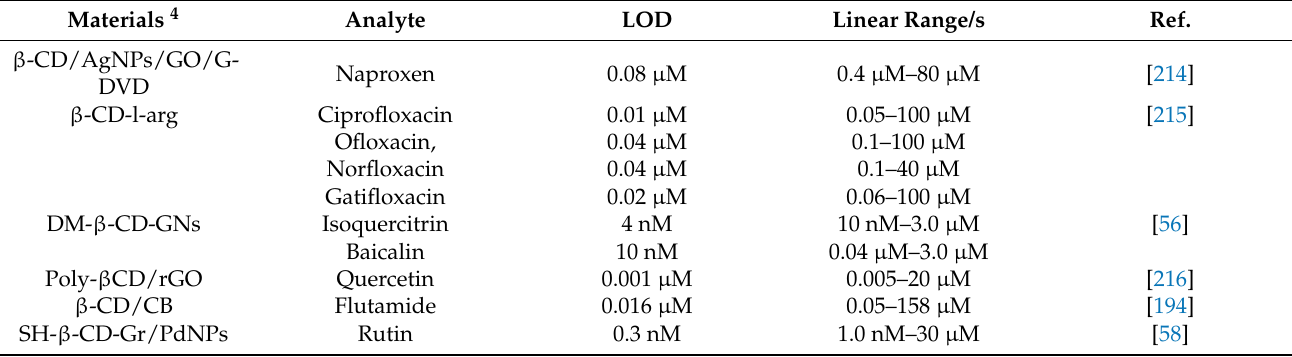
Table 5. Summary of some of the CD-based sensors employed in the electrochemical determination of drugs and